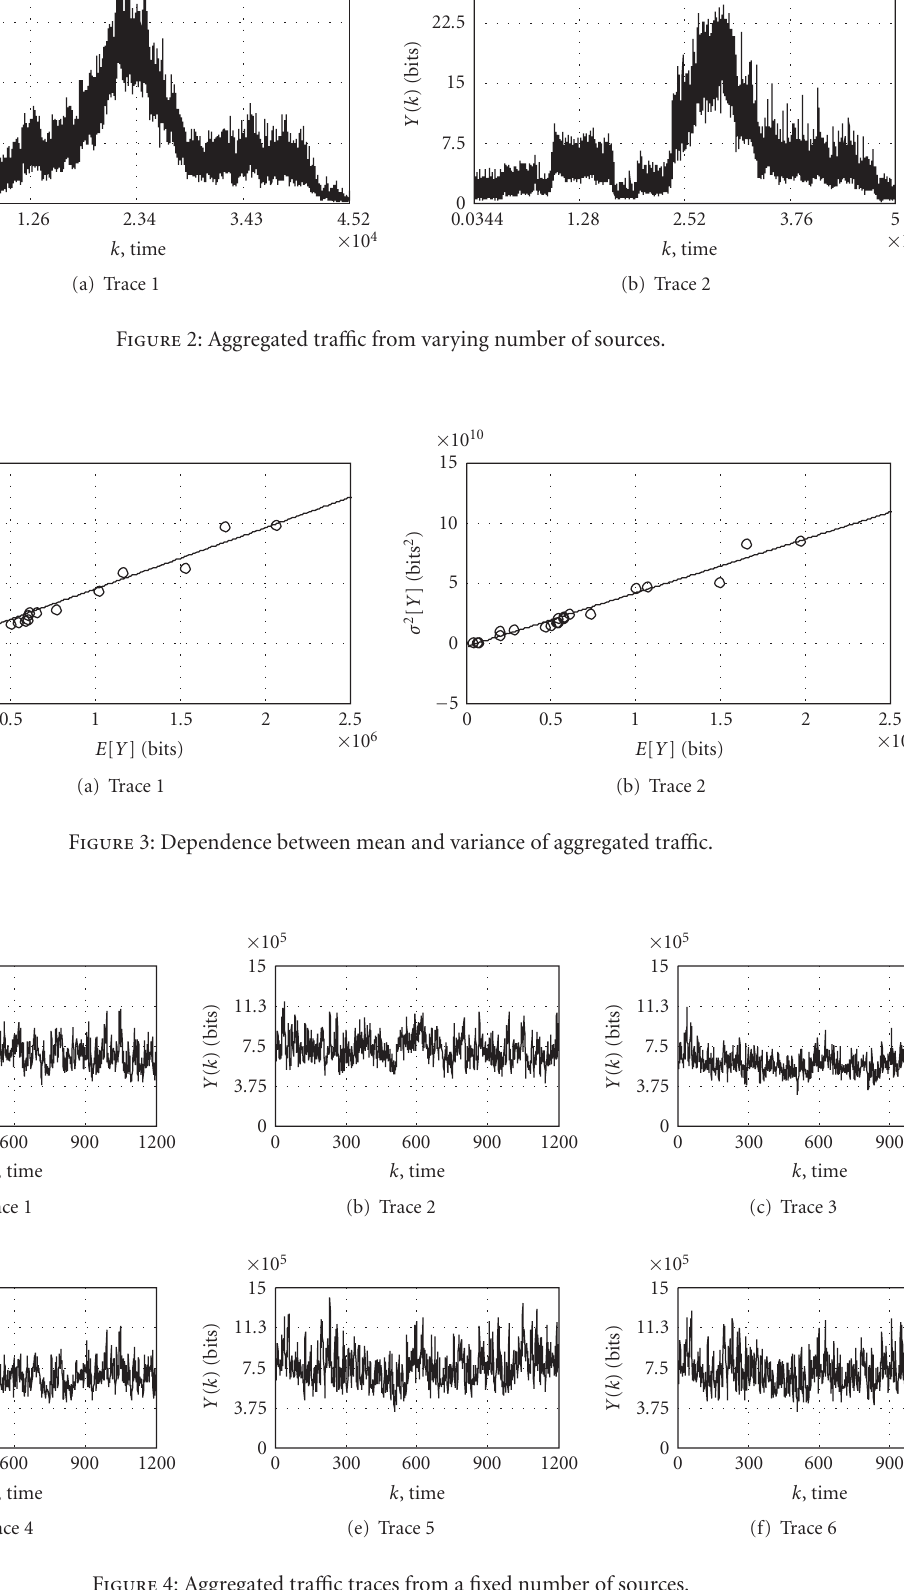
Figure 4: Aggregated tra ffi c traces from a fixed number of